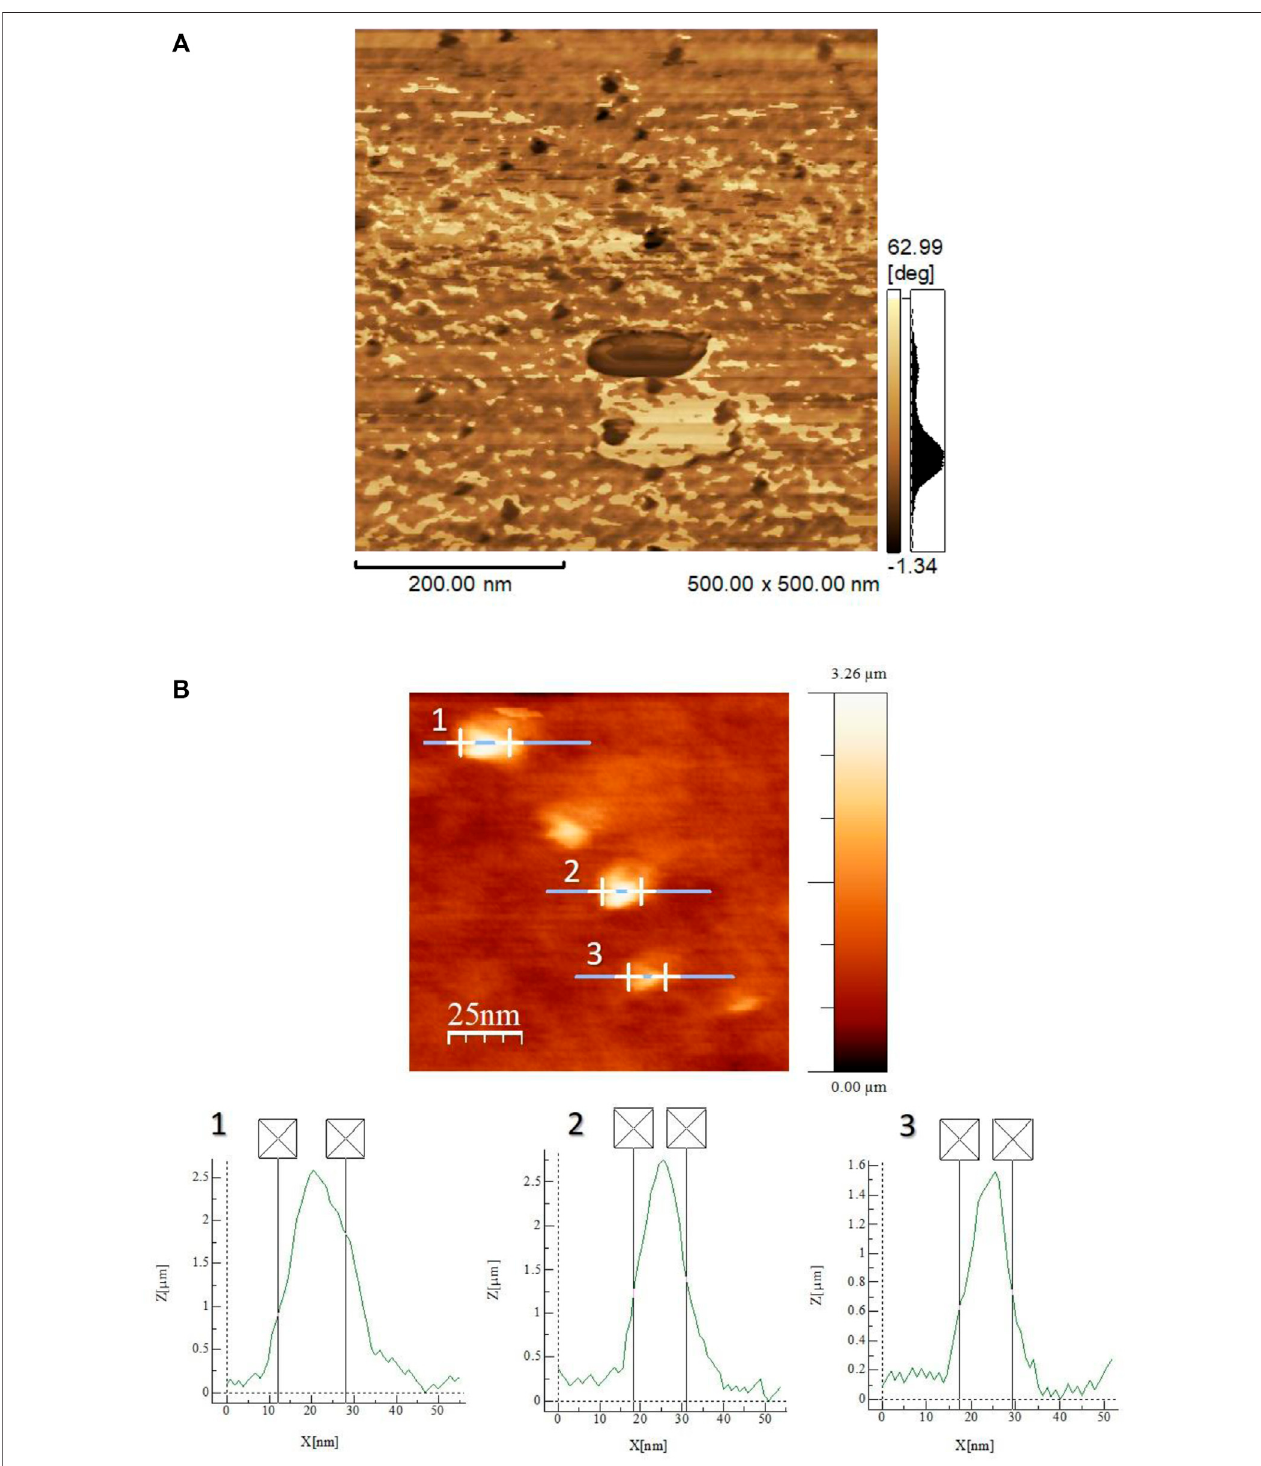
FIGURE6| AFMphase-contrastimage (A) and2DAFMtopographicalimageobtainedinthedynamicmodeandthebrightspotdimensiongraphs (B) ofthe0.03% Er 3+ -doped SiO 2 -Ta 2 O 5 multilayered fi lm prepared by the sol – gel route, deposited on a SiO 2 /Si substrate.